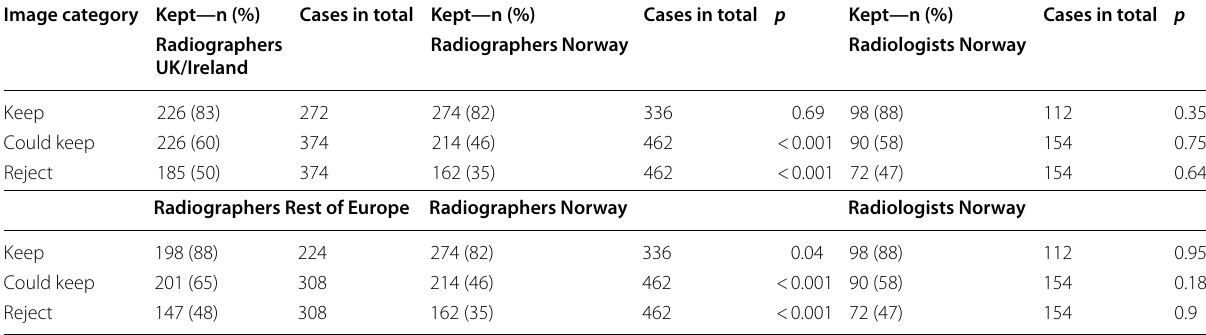
Table 2 Comparing the keep rate for radiographers in Europe to radiographers and radiologists from Norway using the two-tailed chi-square test with 1 degree of freedom. Data from Norway is previously published [11] Image category Kept—n (%) Cases in total Kept—n